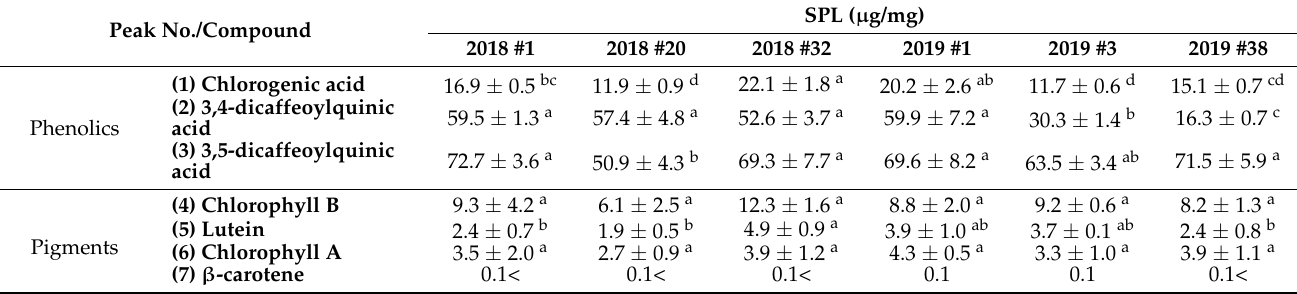
Table 2. Contents of phenolic compounds and pigments in sweetpotato leaves (SPL). Peak